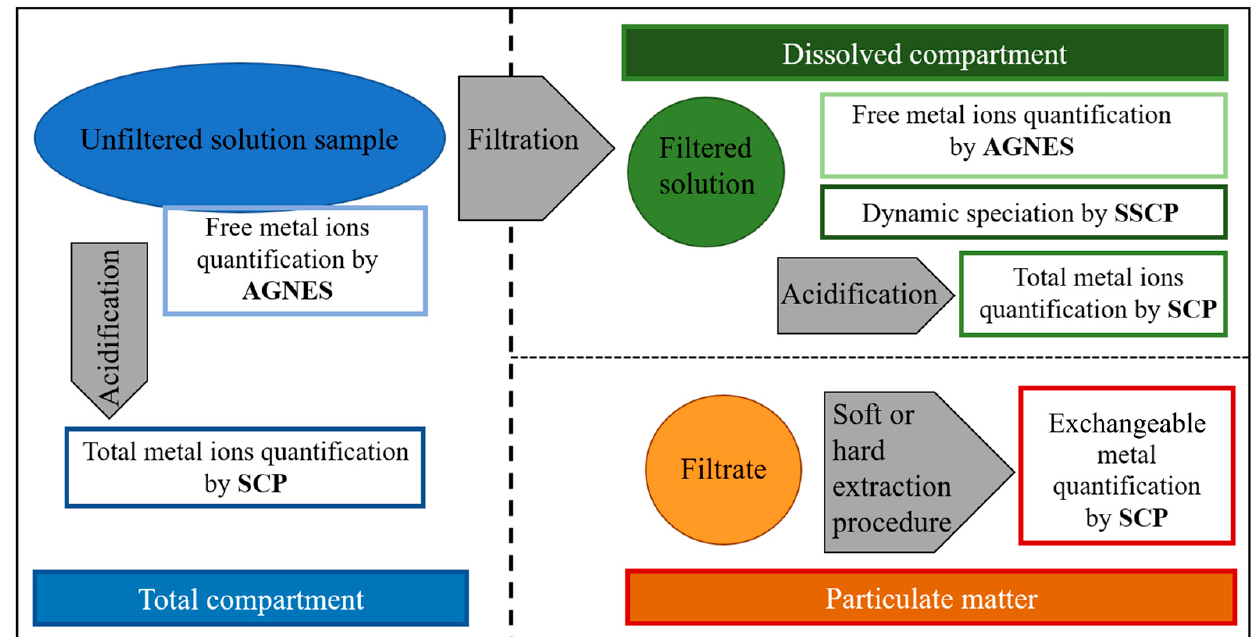
Figure 2. Scheme of the proposed dynamic speciation methodology.